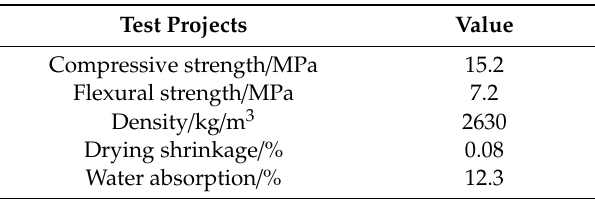
Table 3. Performance index of brick.